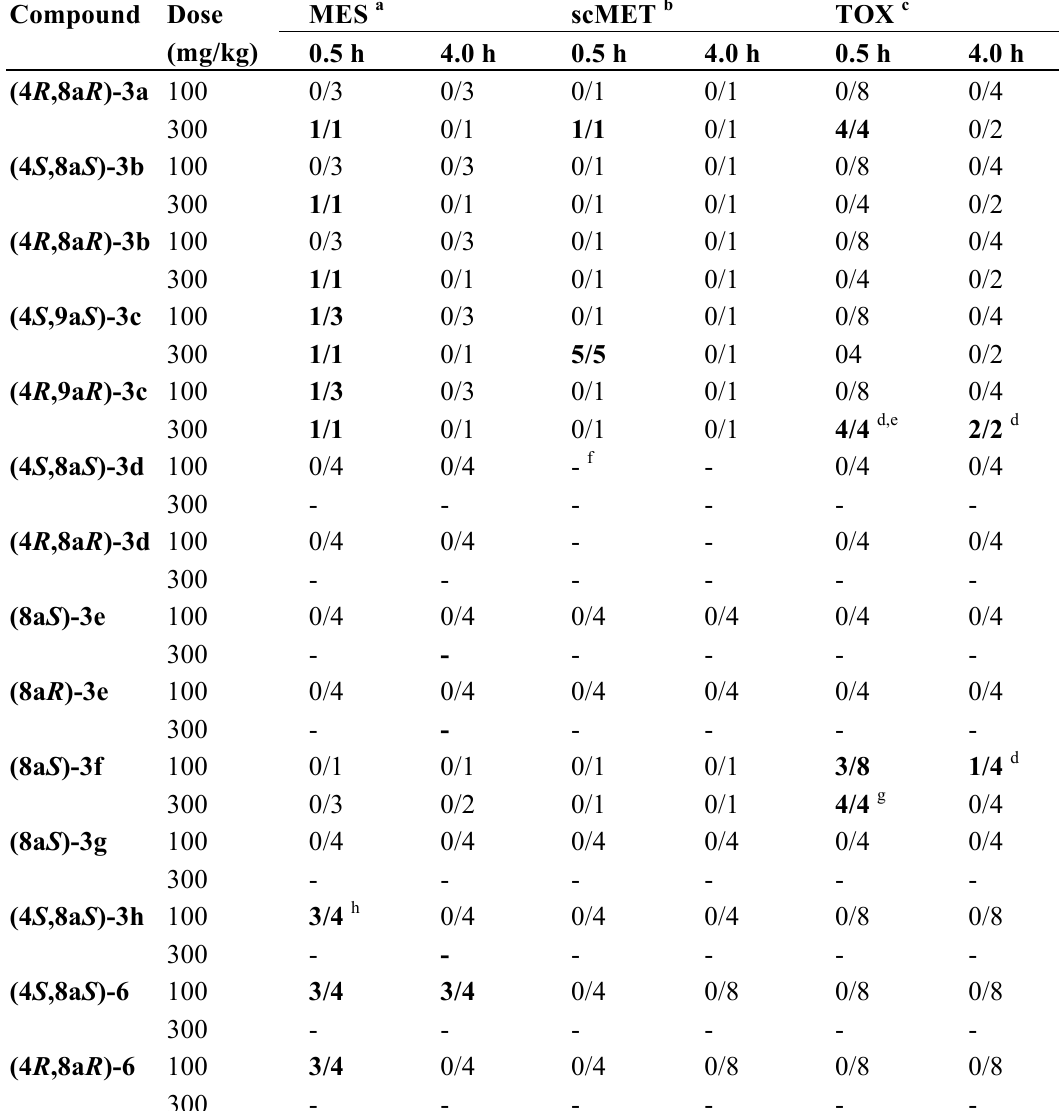
Table 2. Anticonvulsant activity and neurotoxicity of compounds in the MES and scMET models following intraperitoneal (ip.) administration in